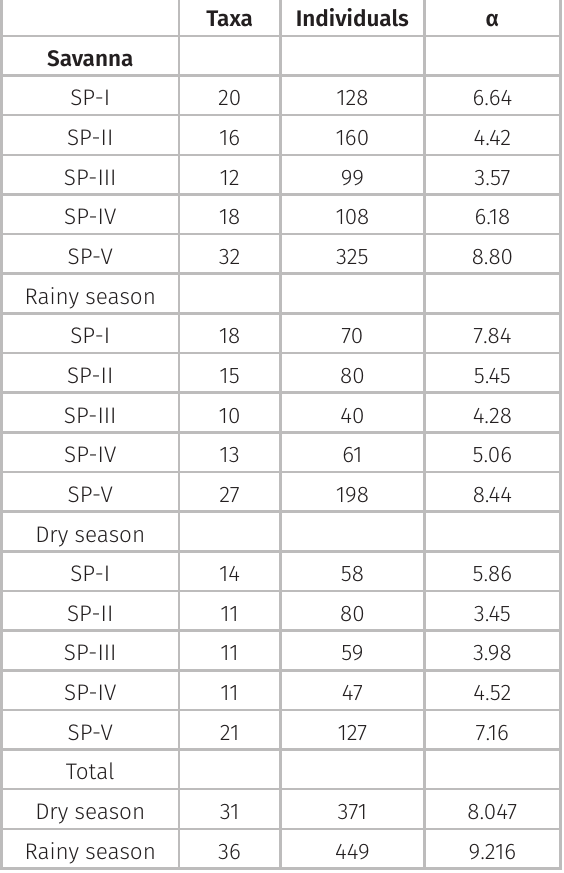
Table III. Fisher’s alpha values calculated for the bryophyte